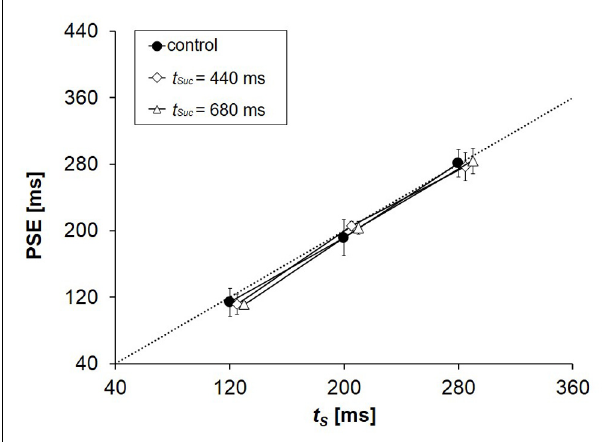
FIGURE 5 | Mean PSEs obtained from five participants in Experiment 4. PSE corresponds to the duration of t C that was perceived to be equal to the duration of t S . Some dots are deviated slightly from the scale marks on the horizontal axis to avoid being invisible in the graph.The physical values of t S (the points of objective equality) are indicated by a dotted line. Error bars represent standard deviations between participants.